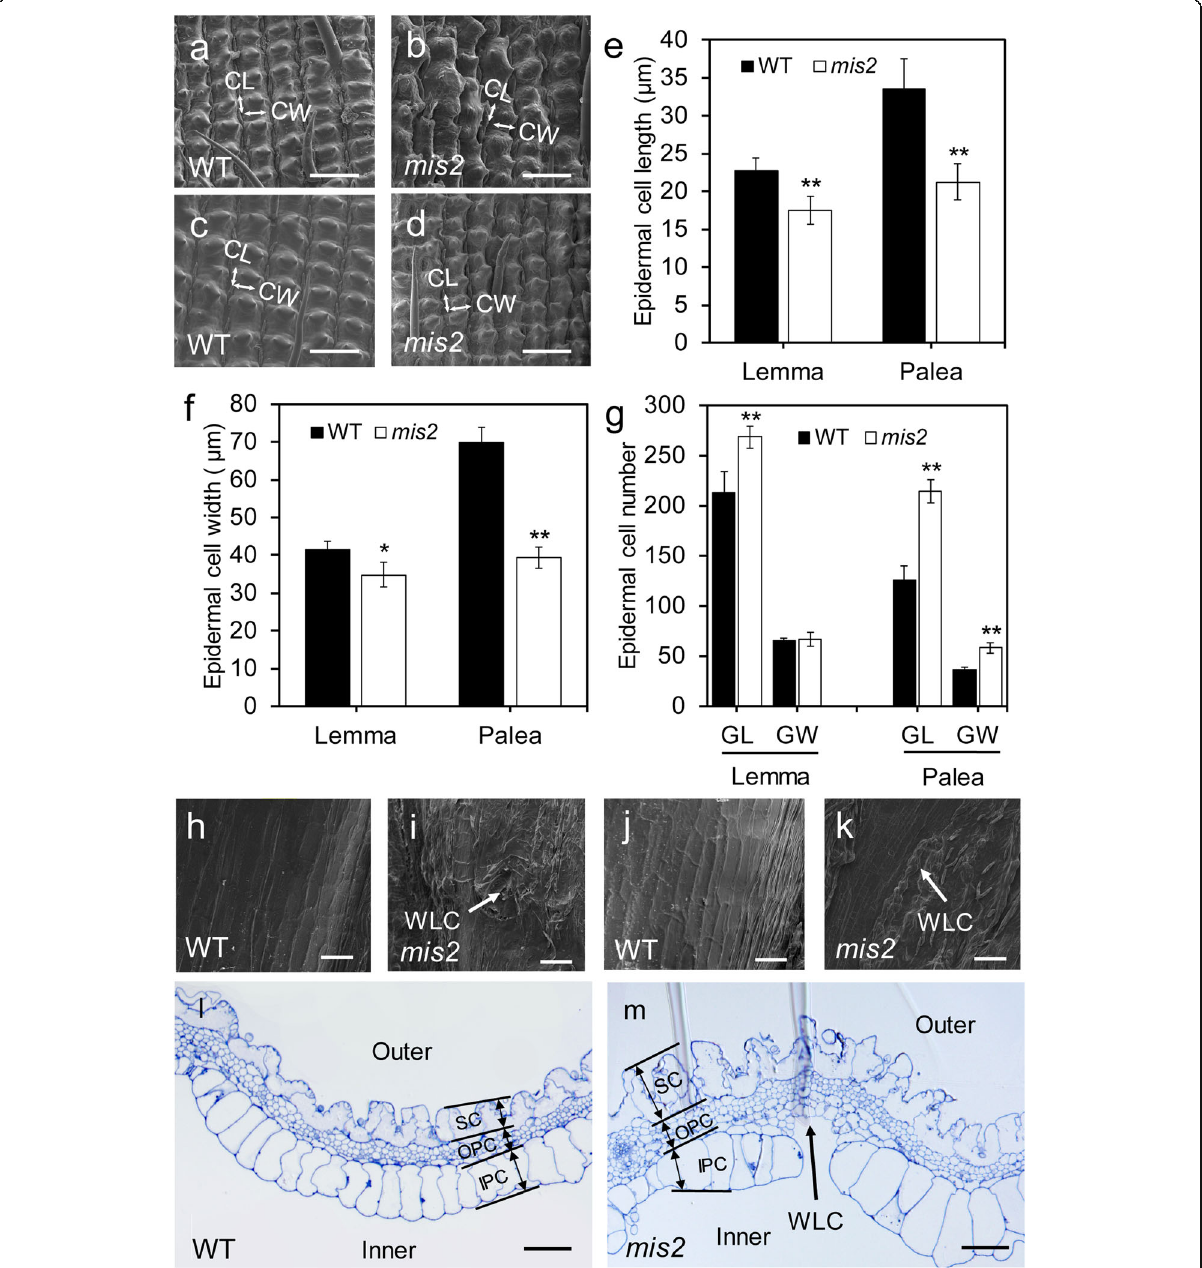
Fig. 2 Comparison of the spikelet epidermal cells between WT and mis2 . ( a - d ) Scanning electron micrographs (SEM) for the outer surfaces of lemma ( a , b ) and palea ( c , d ) of WT ( a , c ) and mis2 ( b , d ). CL and CW indicate epidermal cell length and cell width orientation, respectively. Bars = 100 μ m. ( e , f ) The average length and width of the epidermal cells. ( n = 10). ( g ) Comparisons of the calculated epidermal cell number of the lemma and palea in the grain-length (GL) and grain-width (GW) direction, respectively ( n = 10). ( h - k ) SEM for the inner surfaces of lemma ( h , i ) and palea ( j , k ) of WT and mis2 . Bars = 100 μ m. ( l , m ) Cross sections of WT and mis2 spikelet hull. Bar = 50 μ m. WLC, wart-like cells; SC, silicified cells; OPC, outer parenchyma cells; IPC, inner parenchyma cells. * P < 0.05 and ** P < 0.01 by Student ’ s t test. Data are given as mean ± SD ( n =